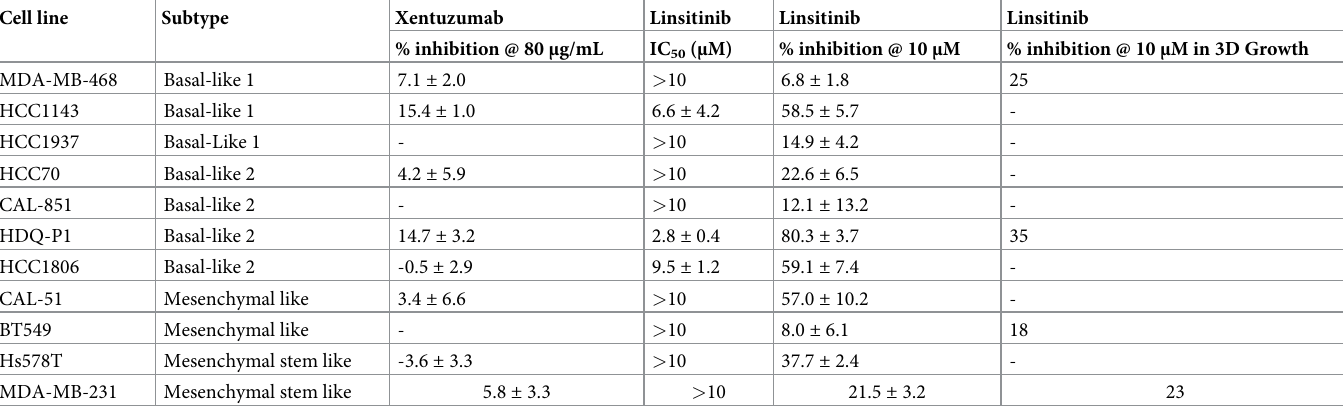
Table 2. Sensitivity to xentuzumab and linsitinib in a panel of TNBC cells was assessed according to sections 2.4 and 2.5. A maximum of 10 μ M Linsitinib and 80 μ g/ mL Xentuzumab was tested in serial dilution to obtain an IC50Average and standard deviations were calculated from triplicate independent assays. 3D assays were from at least duplicate assays. ‘-‘ indicates that no results have been obtained for that cell line under that test